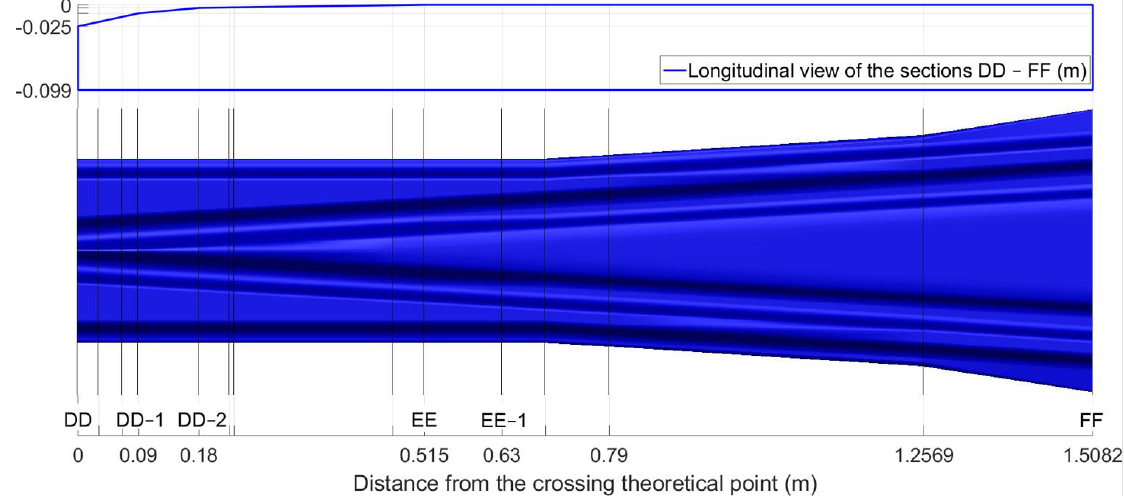
Figure 9. Additional cross-sections between DD and FF.